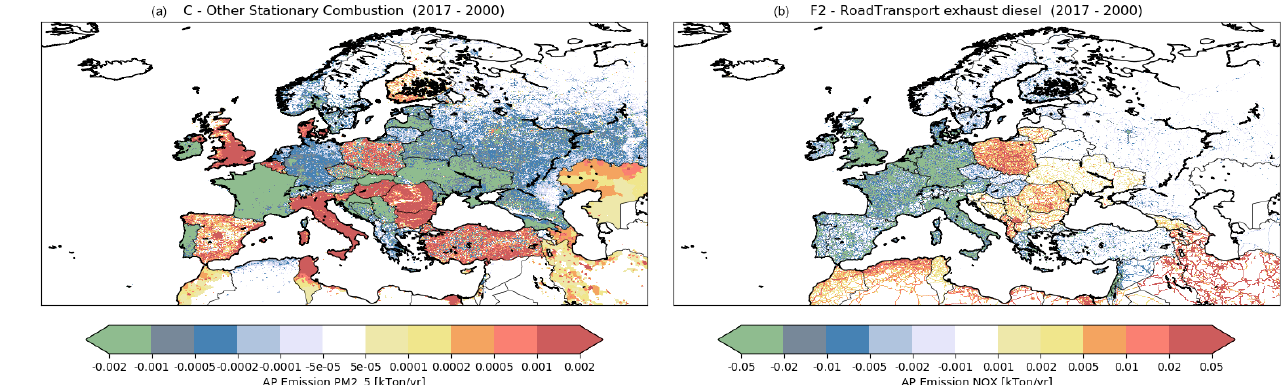
Figure 5. Difference between emissions in 2017 and 2000 for PM 2 . 5 from small combustion (a) and NO x from road transport and diesel exhaust (b) . Figures exclude international shipping.